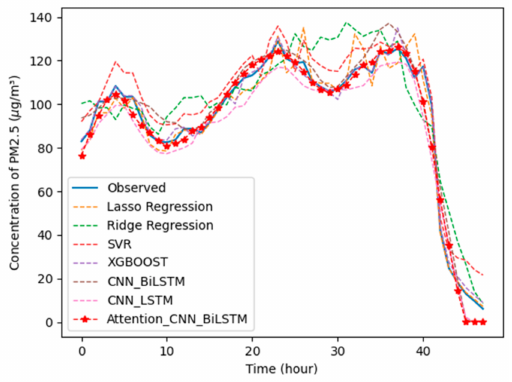
Figure 11. Comparisons of predicted and observed values of each model.